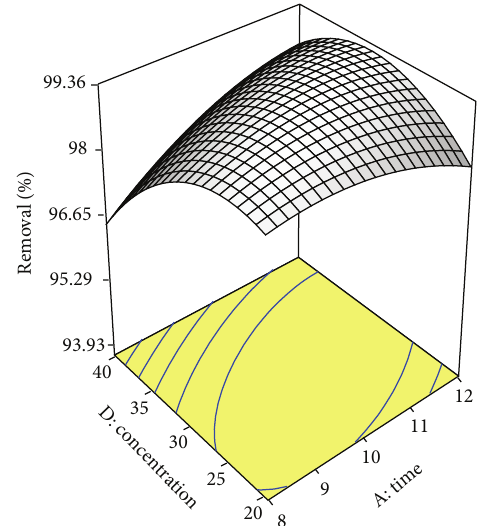
Figure 4: Response surface plot showing the effect of contact time and concentration of lead and their mutual effect on the removal of lead using tartrate-Mg-Al layered double hydroxide.